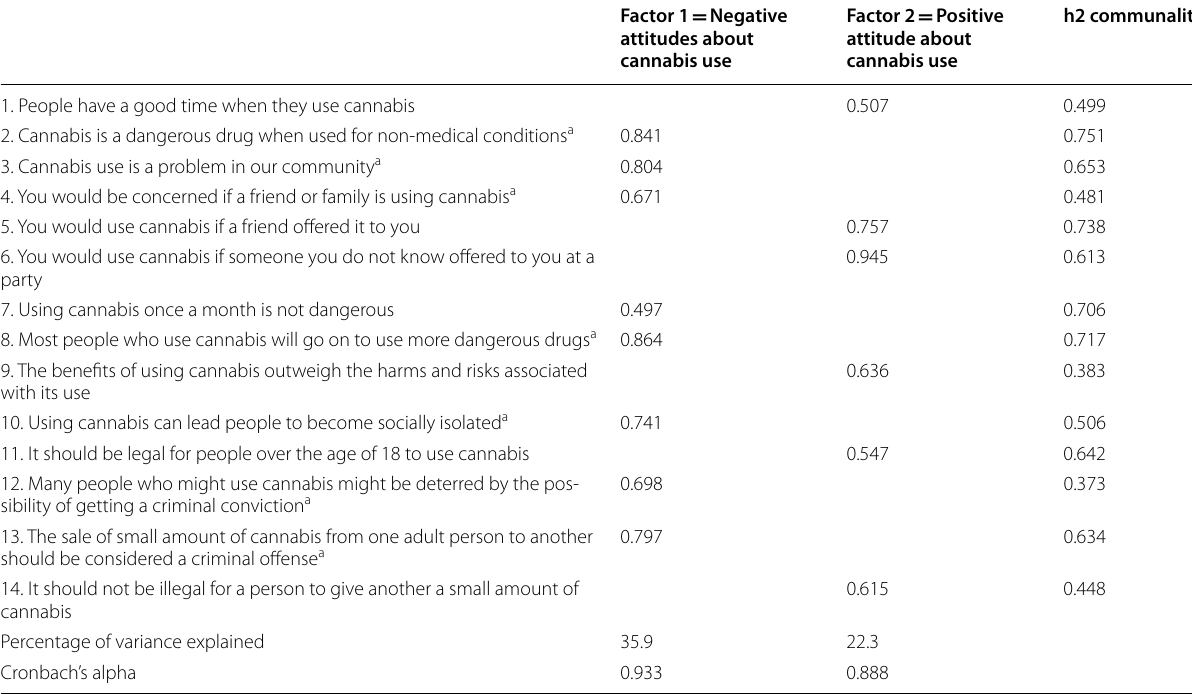
Table 3 Factor analysis of the attitude about cannabis use items using a promax